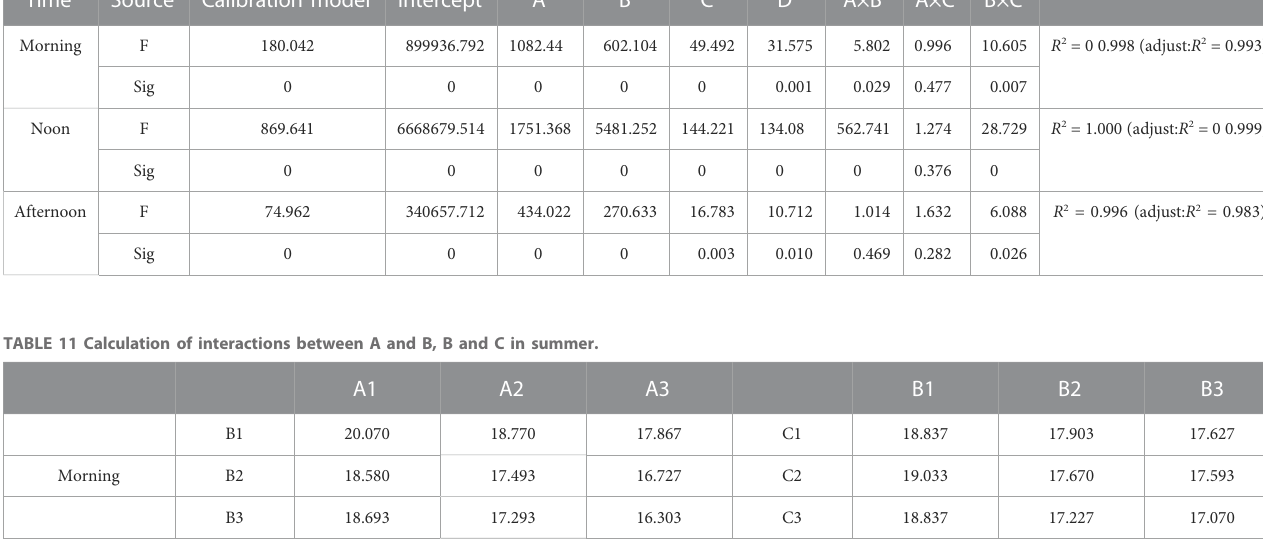
TABLE 10 Analysis of variance results of various factors in summer.